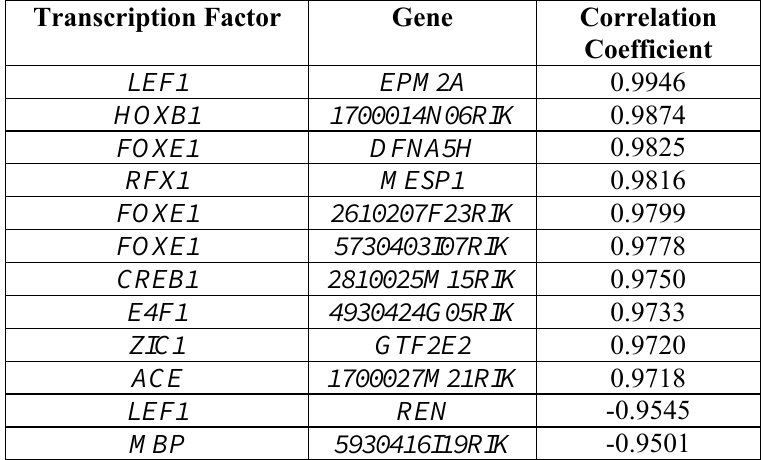
Table 2: List of top ten highly correlated (both positively and negatively) mouse genes with corresponding transcription factors (here, α =